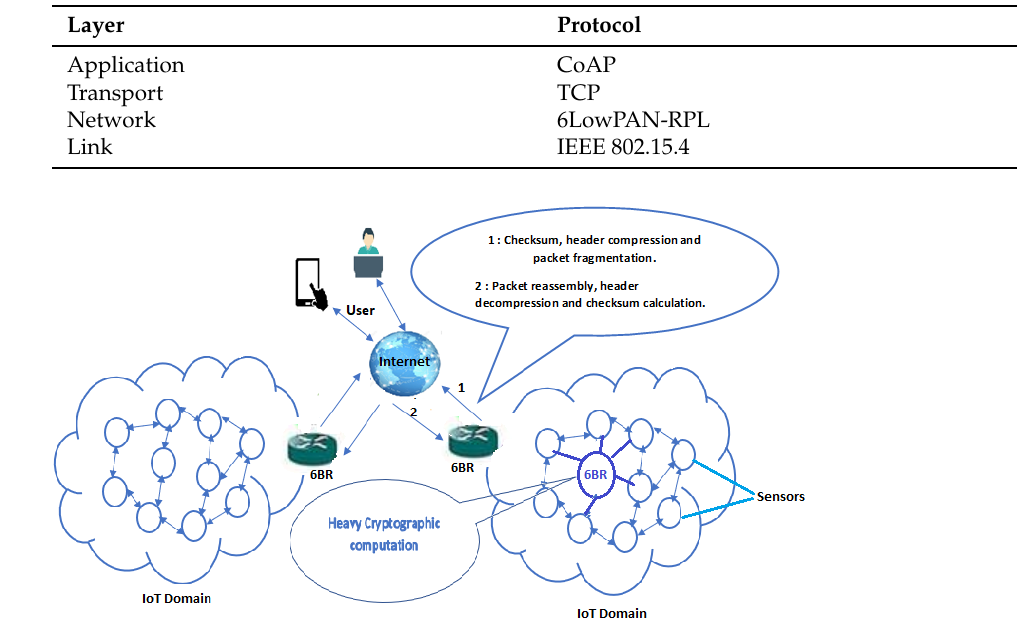
Table 4. Used protocols on the network layers.